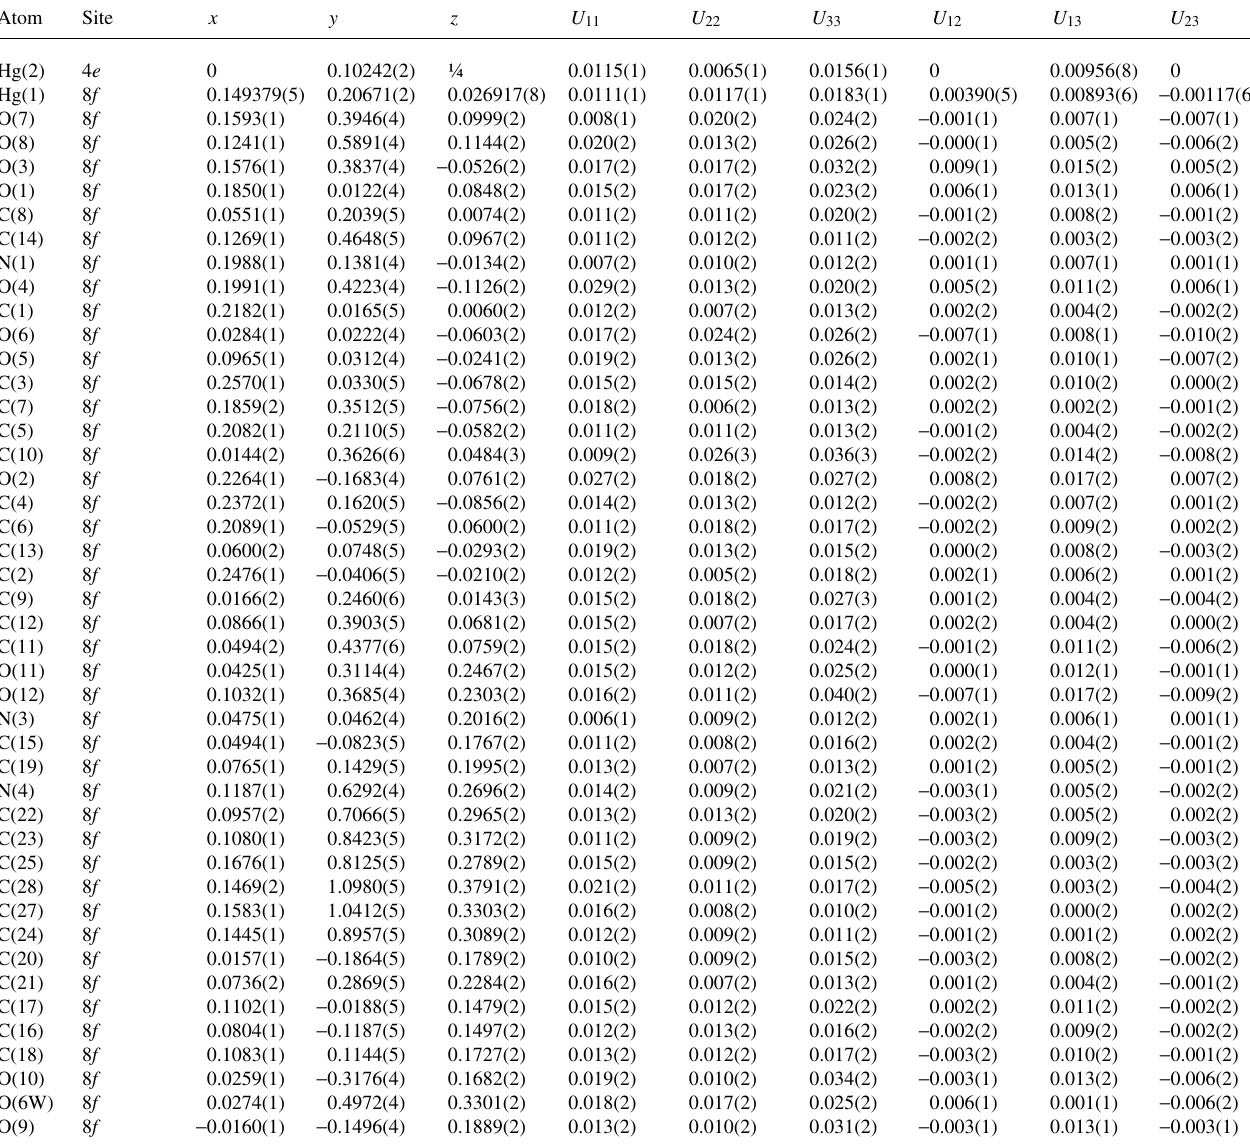
Table 3. Atomic coordinates and displacement parameters (in Å 2 ) .